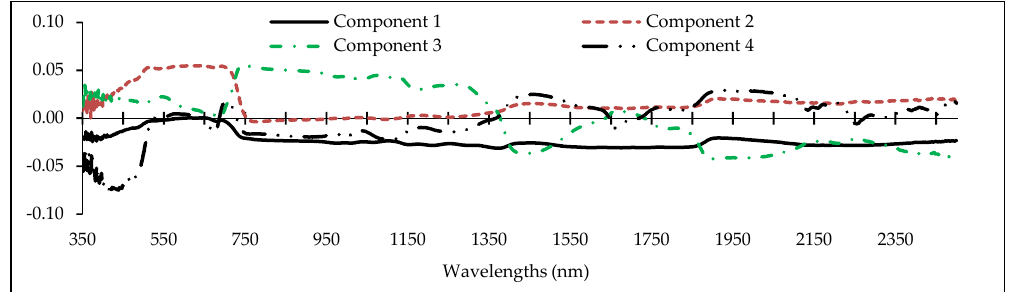
Figure 4. The factor load of wavelengths (350–2500 nm) in the optimal components extracted by the partial least squares (PLS) method for estimating heavy metal concentrations (from top to bottom) in the grapevine leaves (vertical axis is the factor load).